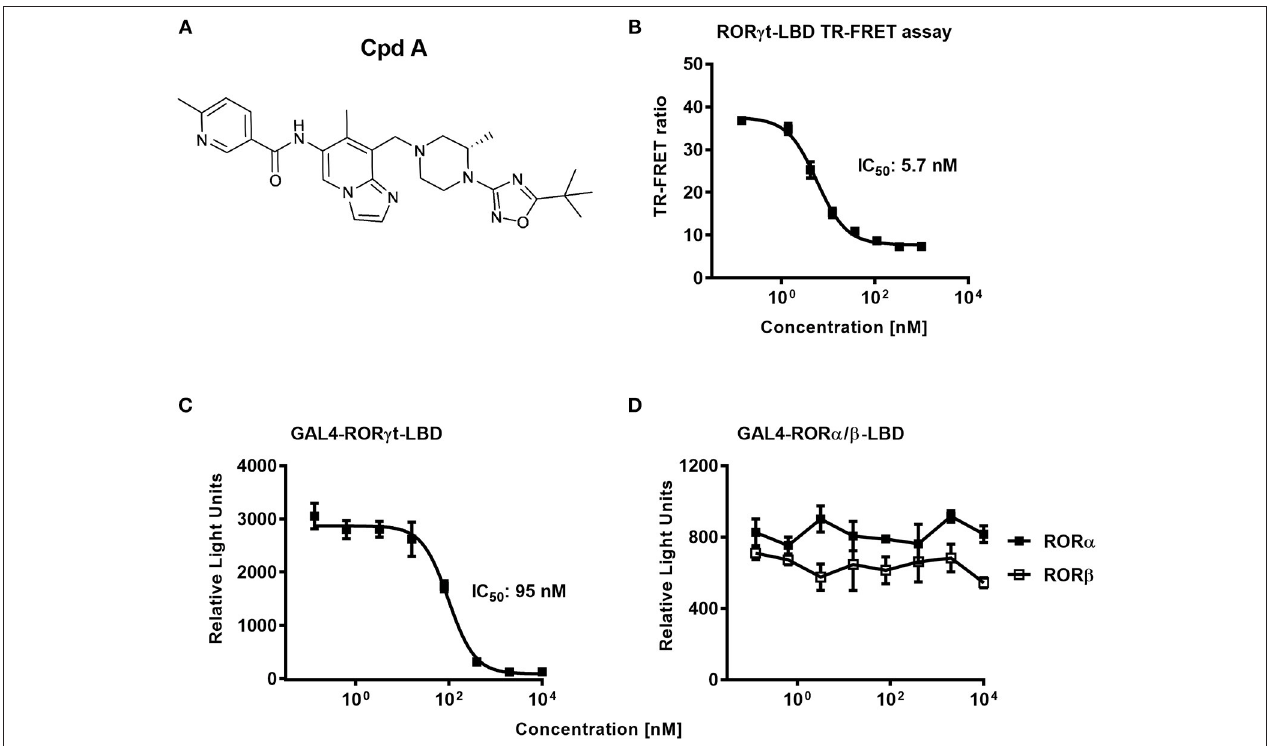
FIGURE 1 | The ROR γ t inhibitor Cpd A prevents co-activator peptide binding to the ligand binding domain of ROR γ t and inhibits transcriptional activity of ROR γ t in a GAL4 reporter gene assay in Jurkat T-cells. (A) Chemical structure of the low molecular weight ROR γ t inhibitor Cpd A. (B) Biochemical TR-FRET assay quantifying the interaction between a RIP140 co-factor peptide with the human ROR γ t-LBD. Representative concentration-dependent curve from at least five independent experiments with duplicate readings is shown. The mean IC 50 value ± SD of the published ROR γ t inhibitor SR2211 was 4.3 ± 4.3nM as determined in two experiments. (C,D) Cpd A is a potent and selective ROR γ t inhibitor in a cellular ROR γ t-LBD GAL4 transactivation assay and has no impact on the transcriptional activity of the closely related ROR α and ROR β nuclear hormone receptors. All experiments were performed three times with similar results. Error bars represent the SD. The mean IC 50 value obtained for SR2211 in the ROR γ t-LBD GAL4 transactivation assay was 418 ± 84nM ( n = 2).